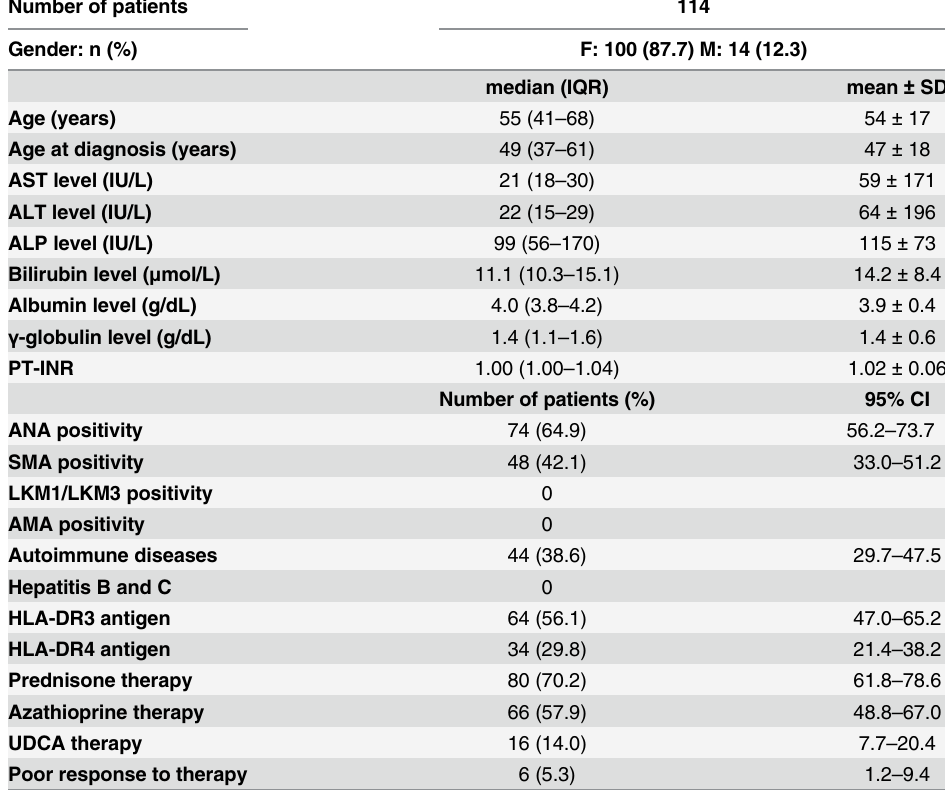
Table 1. Baseline clinical and biochemical parameters of patients affected by type 1 autoimmune hepatitis. Number of